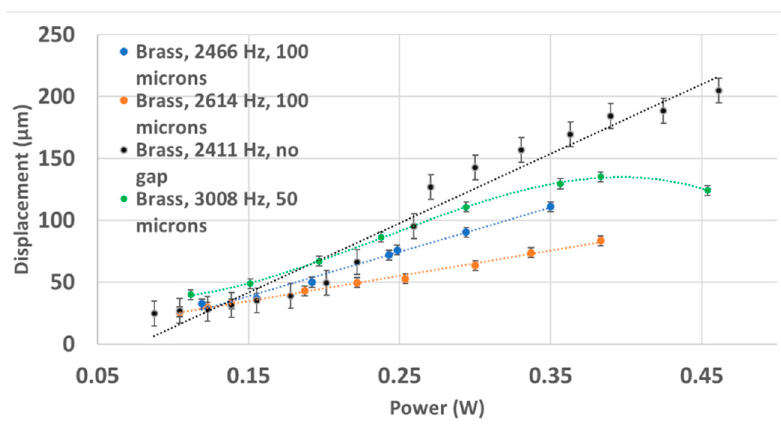
Figure 10. Fiber-tip displacement with response to input power for two aluminum samples with different bridge heights (100 and 150 µm).